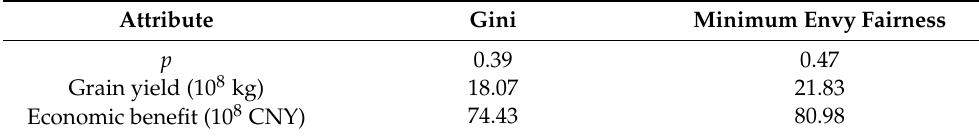
Table 10. Performance of two equity